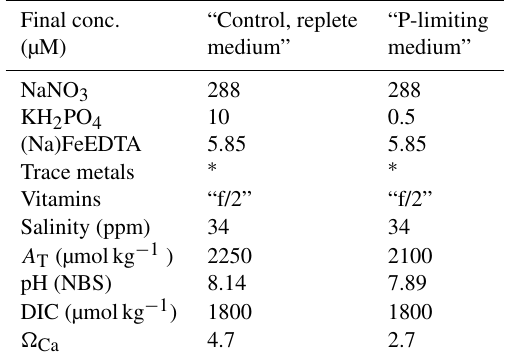
Table 1. Basal composition of the culture media (modified K/2), including salinity and carbonate chemistry ( A T , pH, DIC, (cid:127) Ca ) . ∗ For trace metal composition please refer to the recipe avail- able for K/2 Ian at http://roscoff-culture-collection.org/basic-page/